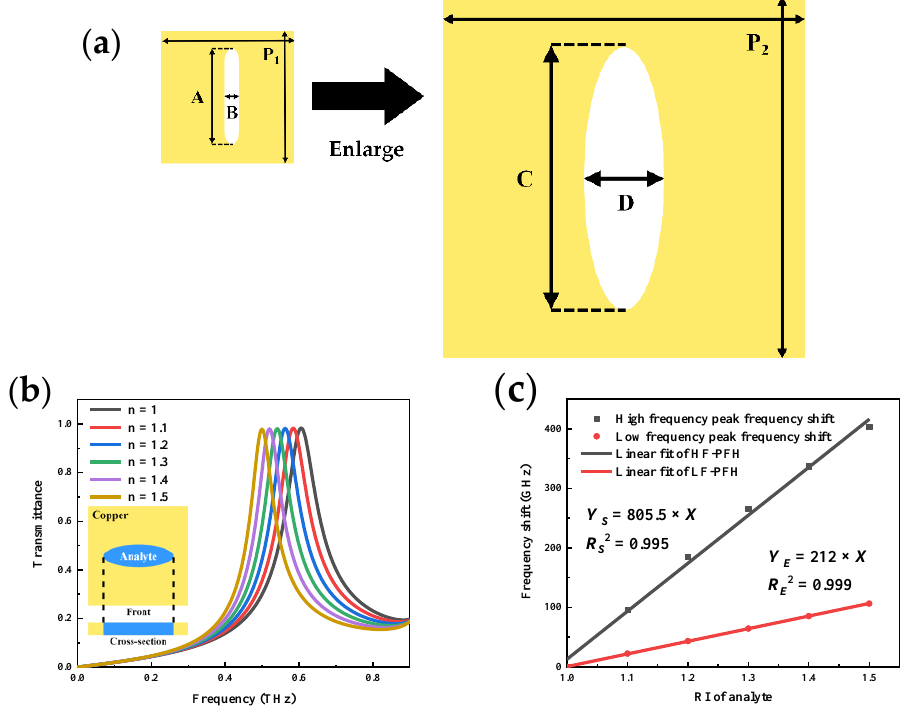
Figure 5. ( a ) Femtosecond laser processing schematic; ( b ) MSA metamaterial microscopy images; ( c ) Same size low-frequency MSA metamaterial microscopic images.